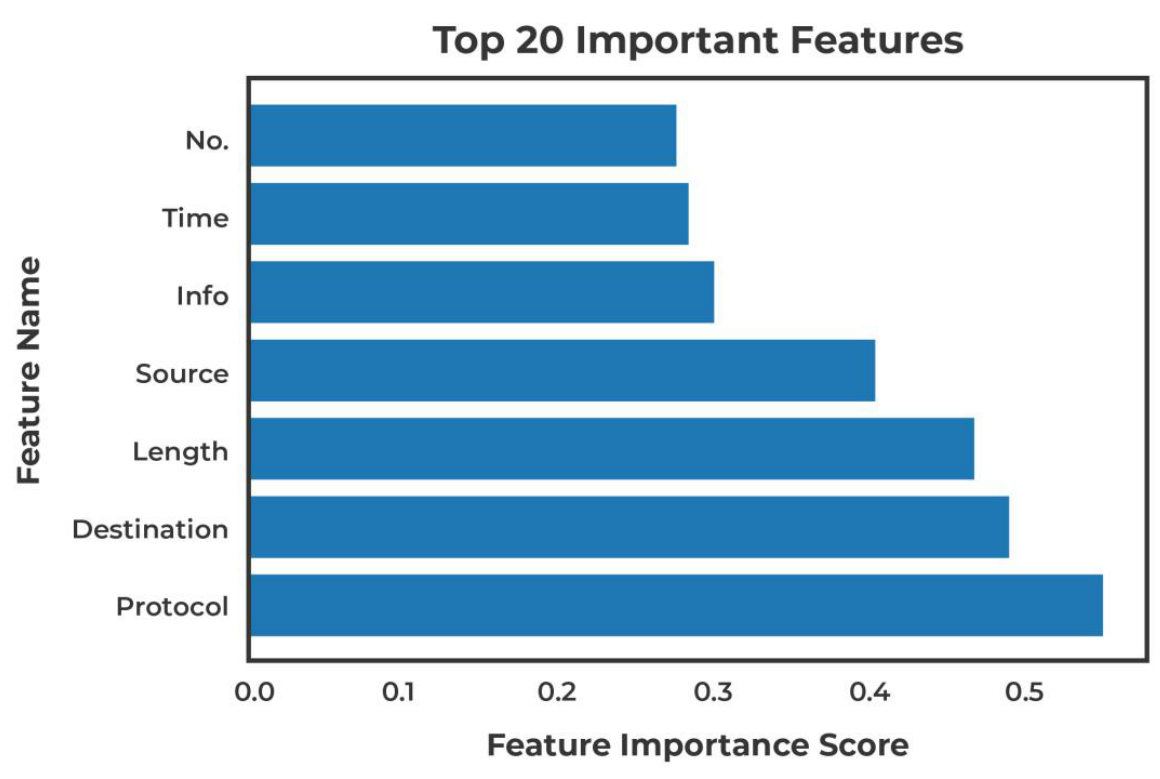
Figure 8. Top 20 Features. The correlation matrix between ten important features is also presented in Figure 9.